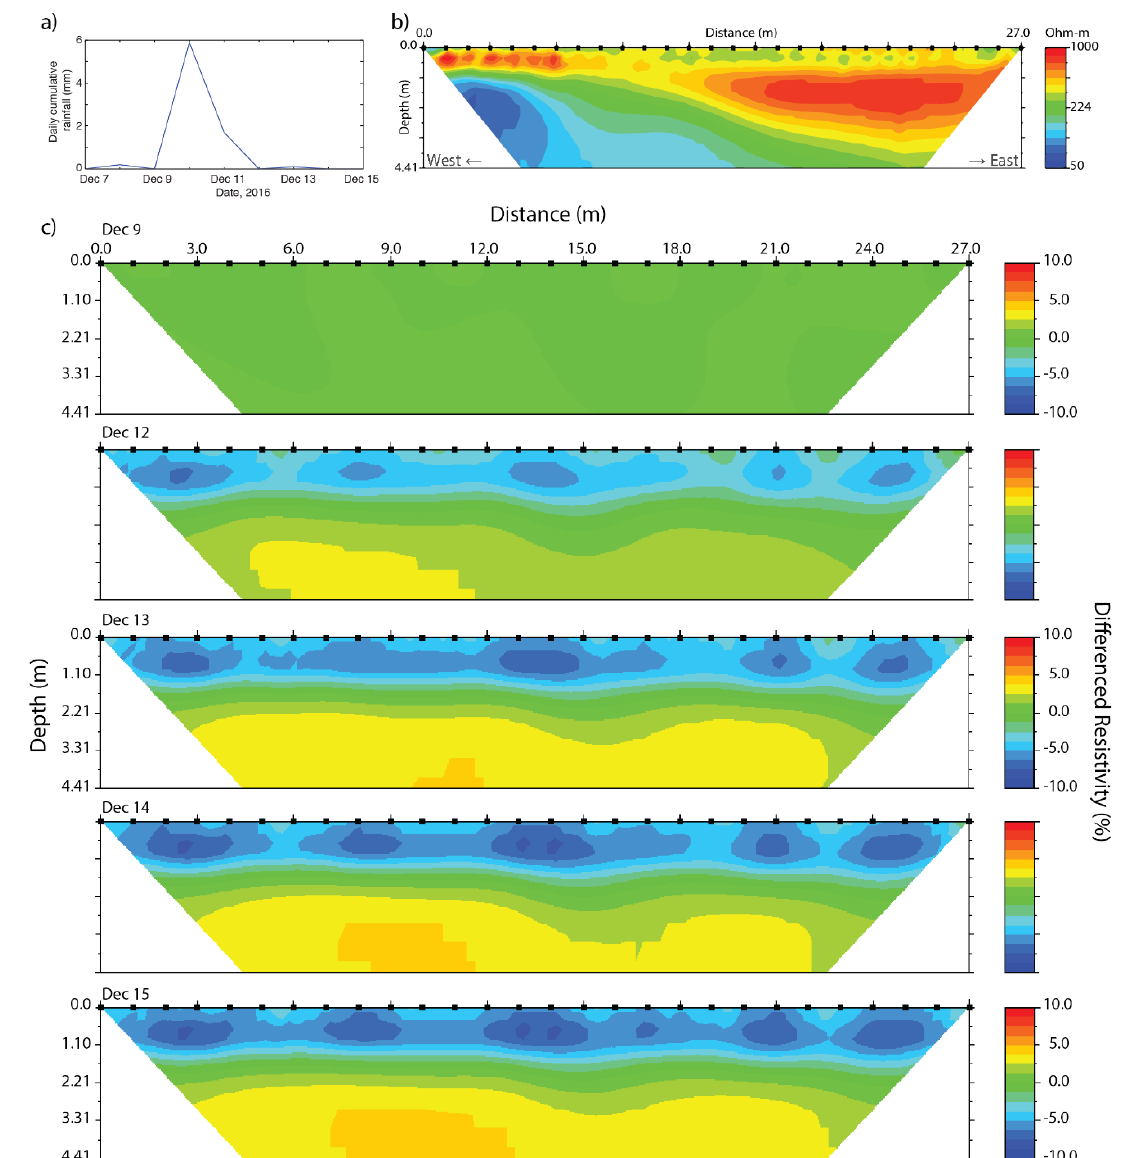
Figure 10. Time-lapse ERT resistivity profiles, illustrating moisture dynamics, with: ( a ) rainfall from 7 to 15 December, ( b ) the base profile of 9 December, and ( c ) the differenced profiles from 9 December to 15 December.